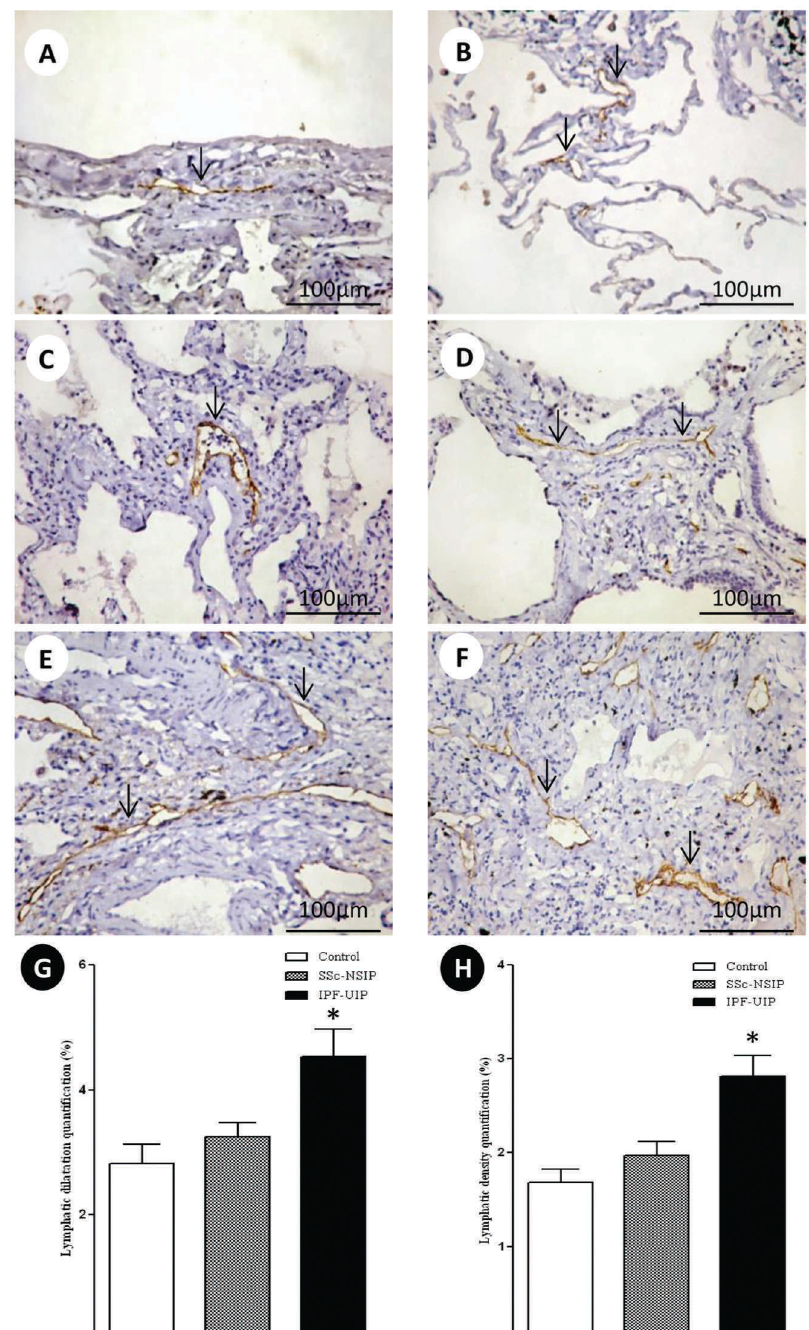
Figure 2 - D2-40 cell expression in the lymphatic vessels of the normal control lungs, systemic sclerosis (SSc) and idiopathic pulmonary fibrosis (IPF). The lymphatic vessels (arrows) were observed in the sub pleural (A) and interlobular septal interstitium (B) in the control lungs. In cellular SSc-NSIP, the lymphatic vessels (arrows) were observed in the thickened alveolar septal region (C) and were infrequent compared to the fibrotic SSc-NSIP pattern (arrows, D). In the UIP pattern, we observed a higher proportion of lymphatic vessels (arrows) in the interlobular and subpleural spaces (E and F). G and H represent the total values of the lymphatic dilatation and density, and the results analyzed by the one-way ANOVA followed by the Bonferroni multiple comparisons test for the control, SSc-NSIP and IPF-UIP groups. (*) A significantly increased lymphatic dilatation (G) was observed in the IPF-UIP group compared to the SSc-NSIP ( p =0.01) and control ( p =0.01) groups. Similarly, a significantly higher lymphatic density (H) was observed in the IPF-UIP group compared to the SSc- NSIP (0.02) and control (0.01)